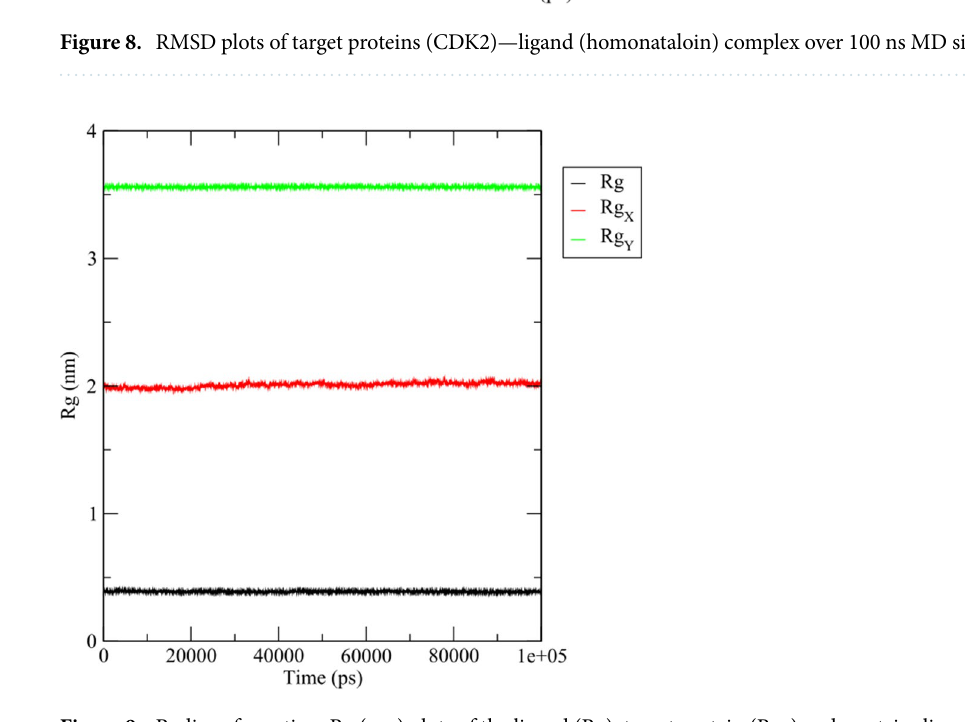
Figure 9. Radius of gyration, Rg (nm) plots of the ligand (Rg), target protein (Rg X ) and protein–ligand complex (Rg Y ) over 100 ns simulation